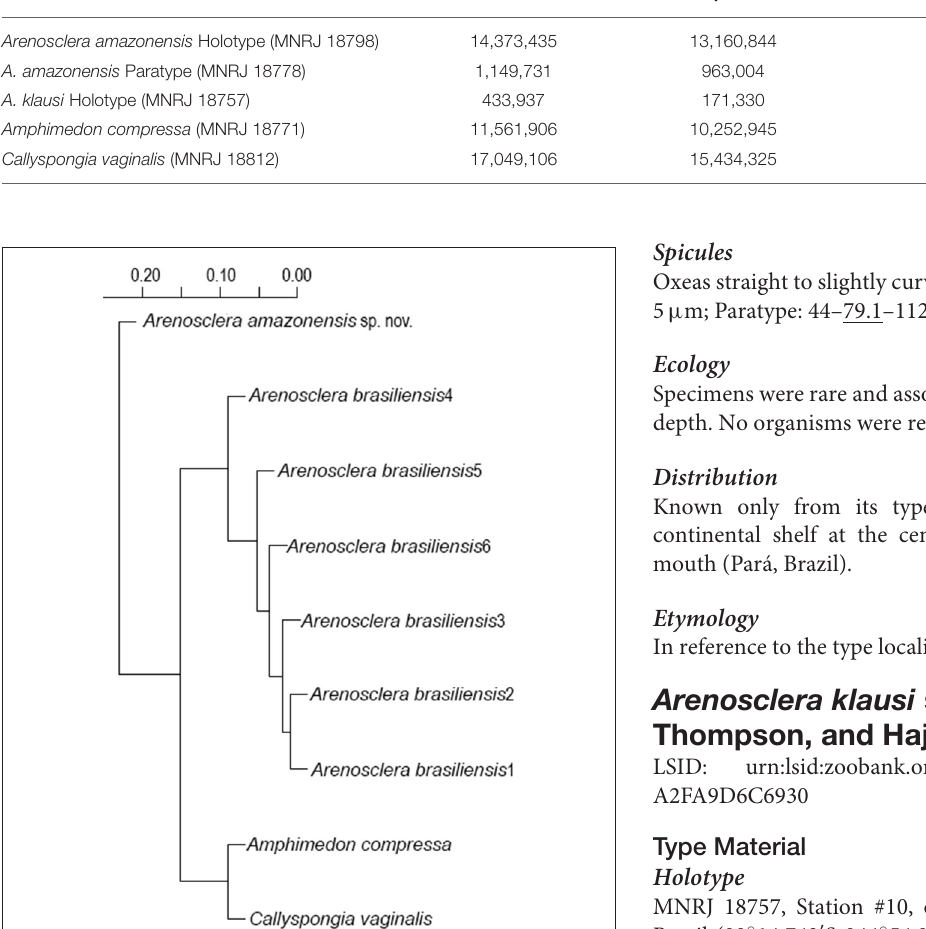
Surface regular, slightly rough to the touch, heavily cored by siliceous sand